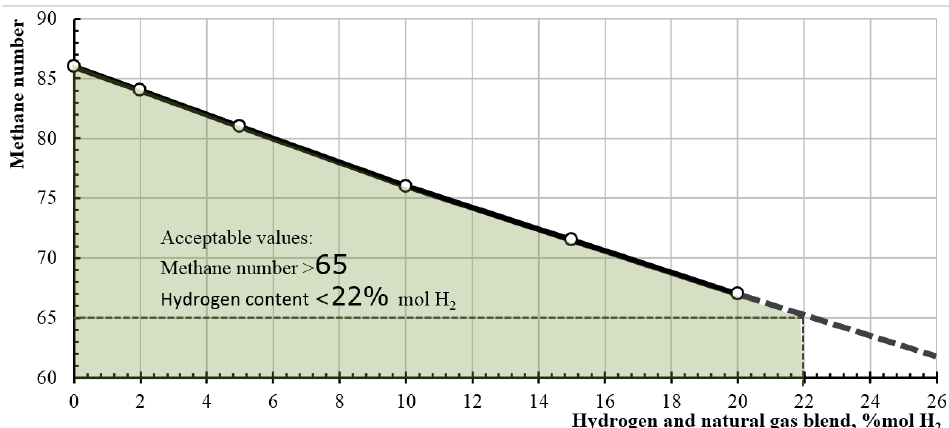
Fig. 4. Methane number based on hydrogen